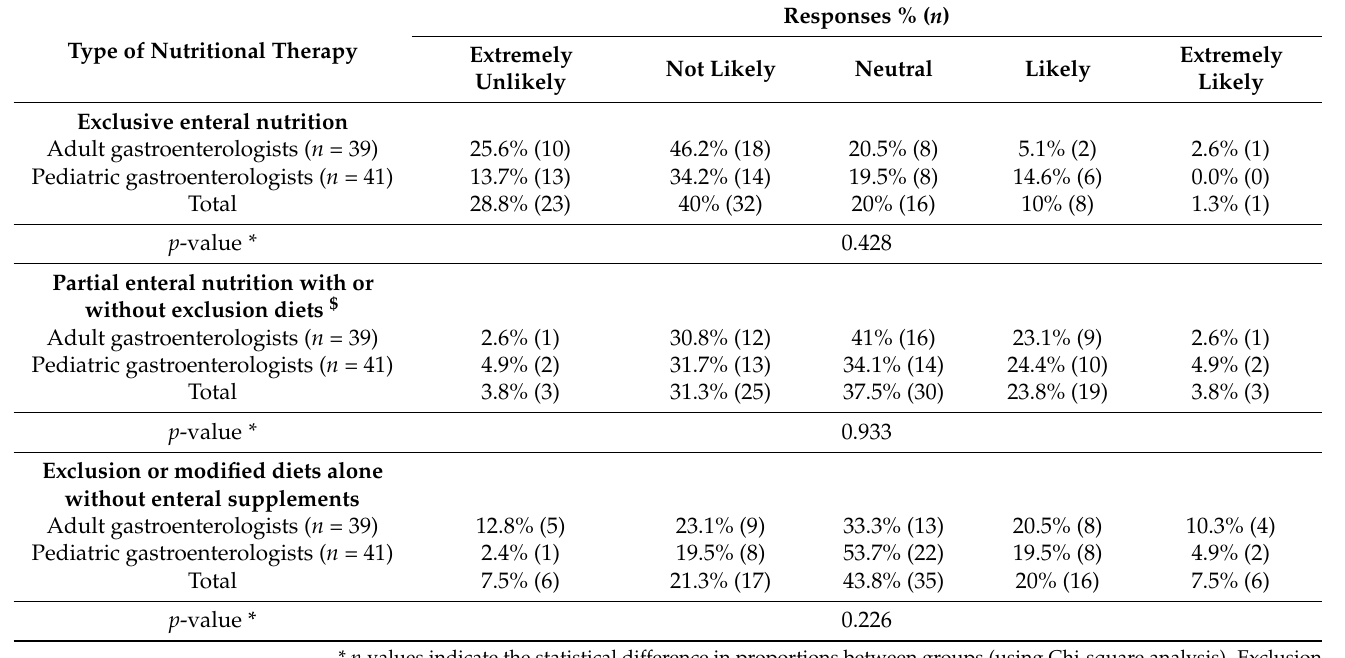
Table 4. Gastroenterologists’ perception of patients’ willingness toward different nutritional therapies ( n =